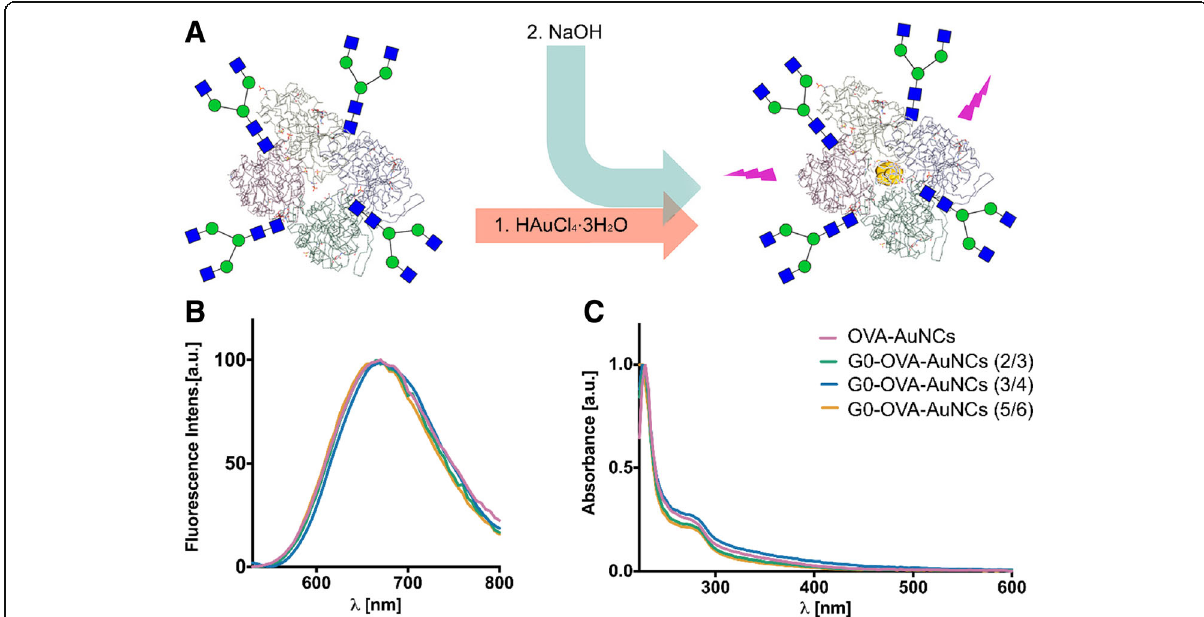
Fig. 3 a Schematic representation of G0 glycan-derived OVA-AuNCs synthesis. b Fluorescence emission spectra of G0-OVA-AuNCs (blue, orange and green lines) compared to OVA-AuNCs (pink line). c UV-visible spectra of G0-OVA-AuNC (blue, orange and green lines) and OVA-AuNC (pink line)